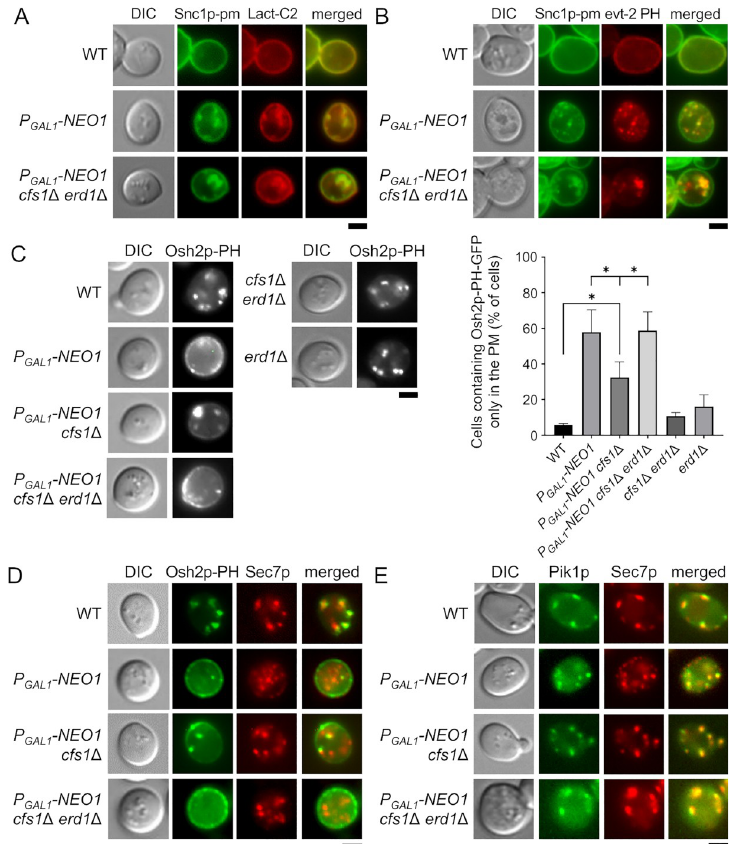
Fig 3. The cytoplasmic leaflet of the TGN in the Neo1p-depleted cfs1 Δ erd1 Δ mutant contains PS and decreased level of PI4P. (A) and (B) PS is exposed to the cytoplasmic leaflet of the TGN in the Neo1p-depleted cfs1 Δ erd1 Δ mutant. (A) Localization of mRFP1-Lact-C2. Cells were cultured in YPDA at 30˚C as in Fig 1C. The strains used were wild type (WT) (YKT2139), P - NEO1 (YKT2158), and P - NEO1 cfs1 Δ erd1 Δ (YKT2142), all of which carry GAL1 GAL1 GFP - SNC1 - pm and pRS416-mRFP1-Lact-C2 (pKT1755). (B) Localization of mCherry-evt-2 PH. Cells were cultured in YPDA at 30˚C as in Fig 1C. The strains used were WT (YKT2139), P - NEO1 (YKT2158), and P - NEO1 cfs1 Δ GAL1 GAL1 erd1 Δ (YKT2142), all of which carry GFP - SNC1 - pm and pRS316-mCherry-evt-2 PH (pKT2205). (C) and (D) PI4P was absent from the TGN in the Neo1p-depleted cfs1 Δ erd1 Δ mutant. (C) Localization of Osh2p-PH-GFP. Left panels : Cells were cultured in YPDA at 30˚C as in Fig 1C. The strains used were WT (YKT2159), P - NEO1 (YKT2160), P - GAL1 GAL1 NEO1 cfs1 Δ (YKT2161), P GAL1 - NEO1 cfs1 Δ erd1 Δ (YKT2162), cfs1 Δ erd1 Δ (YKT2163), and erd1 Δ (YKT2164), all of which carry OSH2 - PH - GFP . Right panel : The percentage of cells with Osh2p-PH-GFP only at the PM was determined ( n = 200) and is expressed as the mean ± standard deviation of five independent experiments. Asterisks indicate a significant difference, as determined by the Tukey–Kramer test ( � : p < 0.01). (D) Localization of Osh2p-PH-GFP and Sec7p-mRFP1. Cells were cultured in YPDA at 30˚C as in Fig 1C. The strains used were WT (YKT2165), P GAL1 - NEO1 (YKT2166), P - NEO1 cfs1 Δ (YKT2167), and P - NEO1 cfs1 Δ erd1 Δ (YKT2168), all of which carry OSH2 - PH - GAL1 GAL1 GFP and SEC7 - mRFP1 . (E) Colocalization of GFP-Pik1p and Sec7p-mRFP1 in the Neo1p-depleted cfs1 Δ erd1 Δ mutant. Cells were cultured in YPDA at 30˚C as in Fig 1C. The strains used were WT (YKT2169), P GAL1 - NEO1 (YKT2170), P - NEO1 cfs1 Δ (YKT2171), and P - NEO1 cfs1 Δ erd1 Δ (YKT2172), all of which carry P - GFP - GAL1 GAL1 PIK1 PIK1 and SEC7 - mRFP1 . Bar, 5 μ m. DIC, differential interference contrast. erd1 Δ mutant [52] and Ers1p may function as a cystine transporter in vacuoles [53]. Sar1p reg- ulates the formation of COPII vesicles from the ER [54], [55], and Yip1p is also implicated in COPII vesicle biogenesis [56]. We confirmed that all these multicopy suppressors suppressed the intracellular accumulation of GFP-Snc1p-pm and mislocalization of Osh2p-PH-GFP in the Neo1p-depleted cfs1 Δ erd1 Δ mutant (Fig 4D).